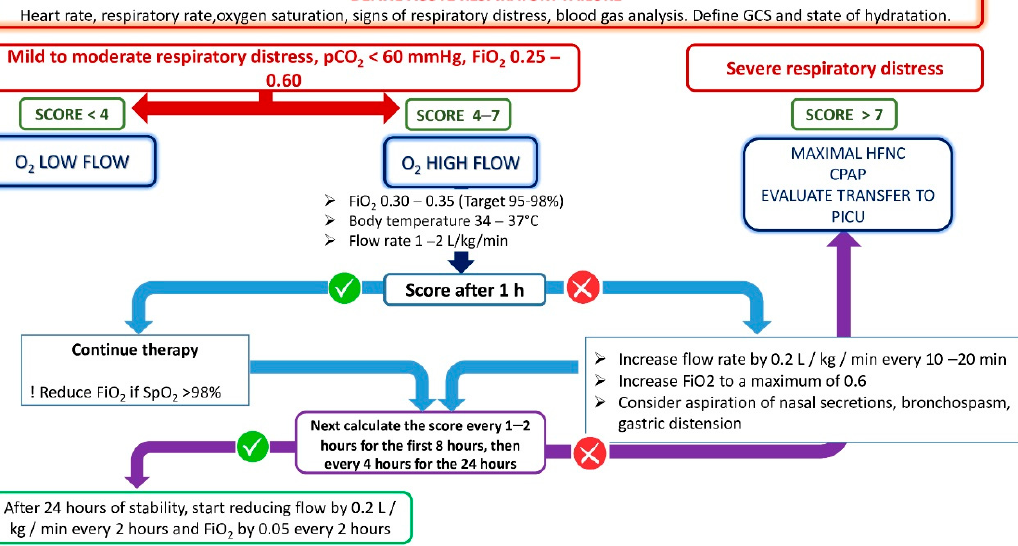
Figure 1. Decisional flow-chart for the management of high-flow oxygen therapy in children. The Pediatric Early Warning System was considered as the score. GCS = Glasgow Coma Scale; pCO 2 = partial pressure of carbon dioxide; FiO 2 = fraction of inspired oxygen; O 2 = oxygen; SpO 2 = blood oxygen saturation; HFNC = high-flow nasal cannula; CPAP = continuous positive airway pressure; PICU = pediatric intensive care unit.